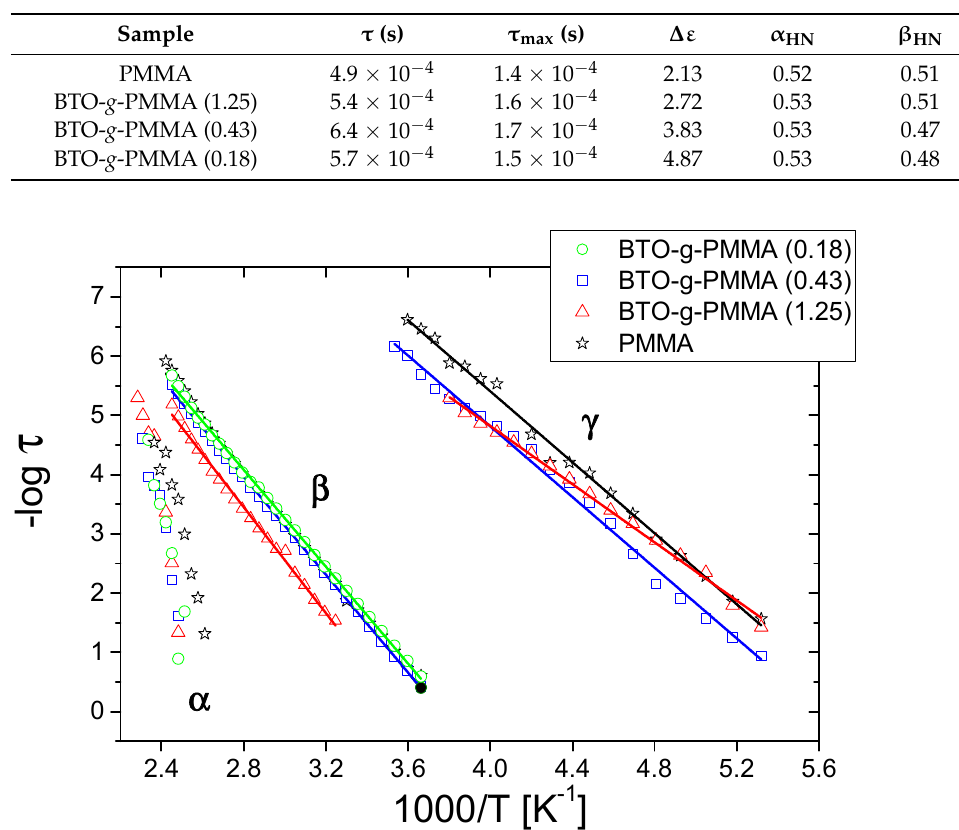
Figure 4. Arrhenius plot for the core–shell BTO- g -PMMA composites performed from BDS experi- ments. Data for PMMA were added for comparison. Table 3. Activation energies of local relaxations calculated for neat PMMA and BTO- g -PMMA core– shell composites.